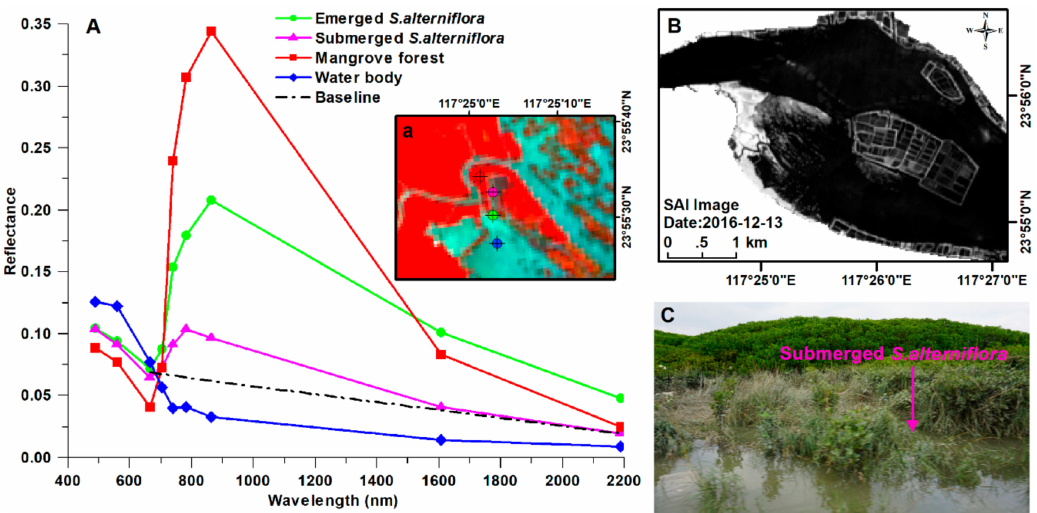
Figure 2. The submerged S. alterniflora index (SAI) and submerged S. alterniflora pixels. ( A ) Spectral reflectance curves of mangrove forest, exposed S. alterniflora (E S. alterniflora ), submerged S. alterniflora ( S. alterniflora ), and water in Sentinel-2 image, and baseline of establishing SAI. ( B ) SAI of the high-tidal Sentinel-2 image. ( C ) A field photo of S. alterniflora